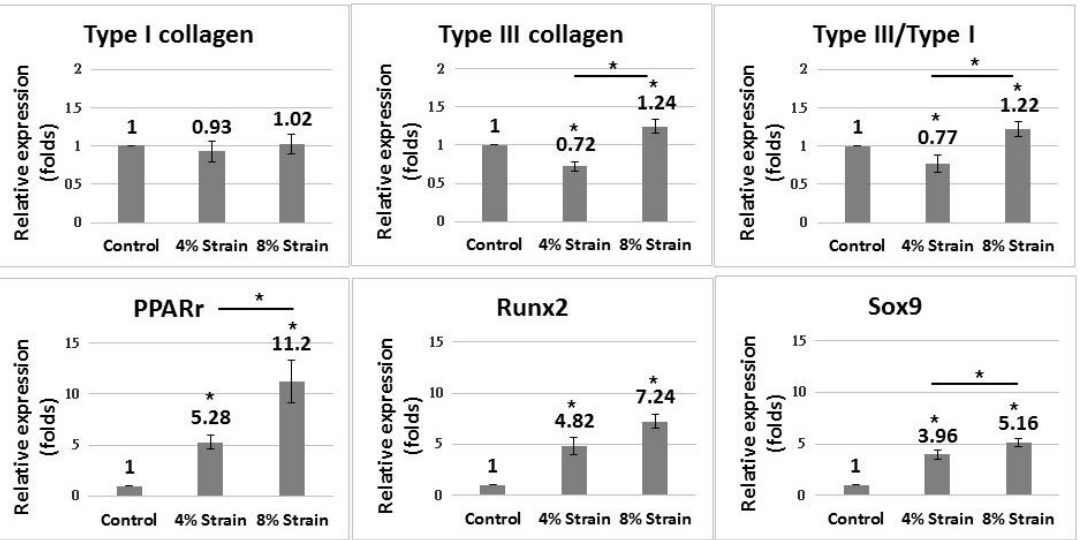
Figure 3. Effect of EGCG on the gene expression of tendon-derived cells (TDCs) subjected to cyclic stretching with 8% strain. Upper panel : Quantitative PCR demonstrated that TDCs with EGCG showed decreased expression of type III/type I collagen genes compared with cells without EGCG. Lower panel : TDCs with EGCG showed decreased expression of Pparg , Runx2 , and Sox9 compared with cells without EGCG. Data are expressed in fold-changes of expression level relative to the control (static culture) presented as mean ± SD ( n = 4, * p < 0.05).